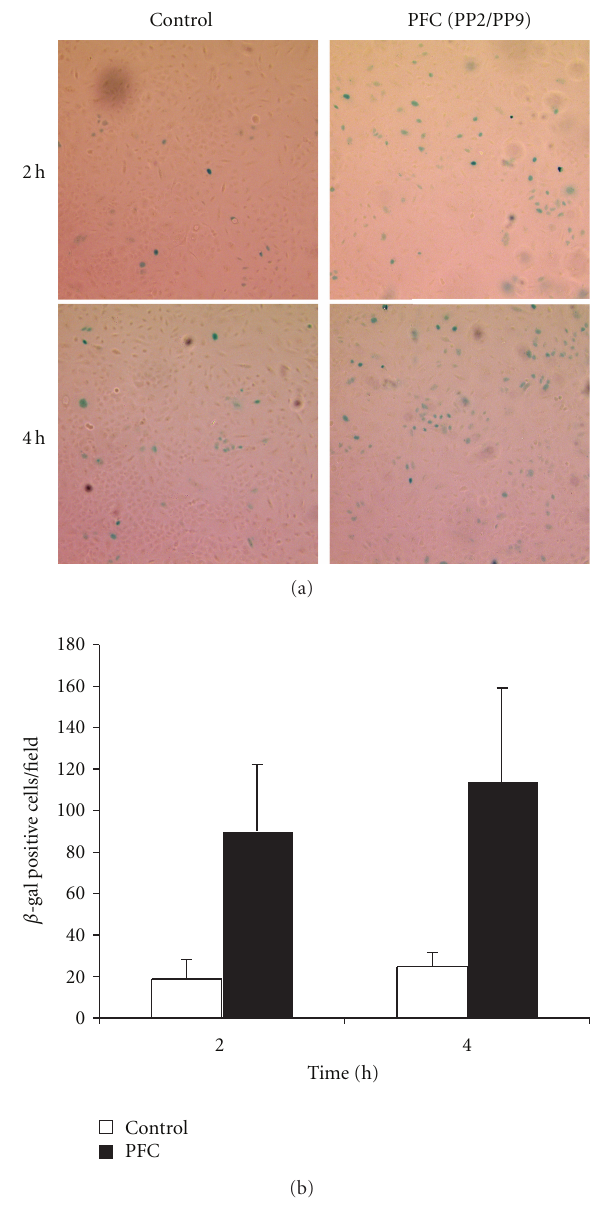
Figure 1: PFC liquid increases transduction e ffi ciency in cell culture. (a) Representative fields of A549 cells transduced with rAd- CMVLacZ (MOI = 100 viral particles/cell) in either saline (Control, left) or PFC liquid (right) for 2h (top) or 4 h (bottom) followed by X-gal staining. (b) Consecutive low-power fields were acquired under identical settings, and β -gal positive cells were enumerated manually. Values represent mean ± SD of 10 fields. ∗ P < 0 . 05 versus